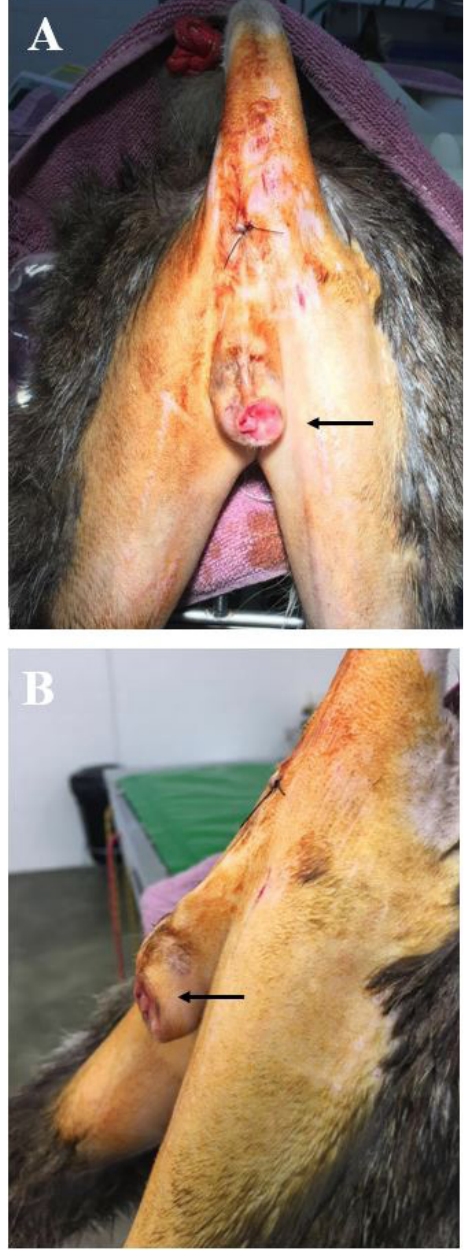
Figure 1. Male feline, 16‑year‑old, Brazilian short‑haired, with foreskin adenocarcinoma. A) Macroscopic image of the lesion in caudal view. Note the foreskin region with increased volume and ulceration (arrow); B) Macroscopic image of the perineal region after penectomy followed by perineal